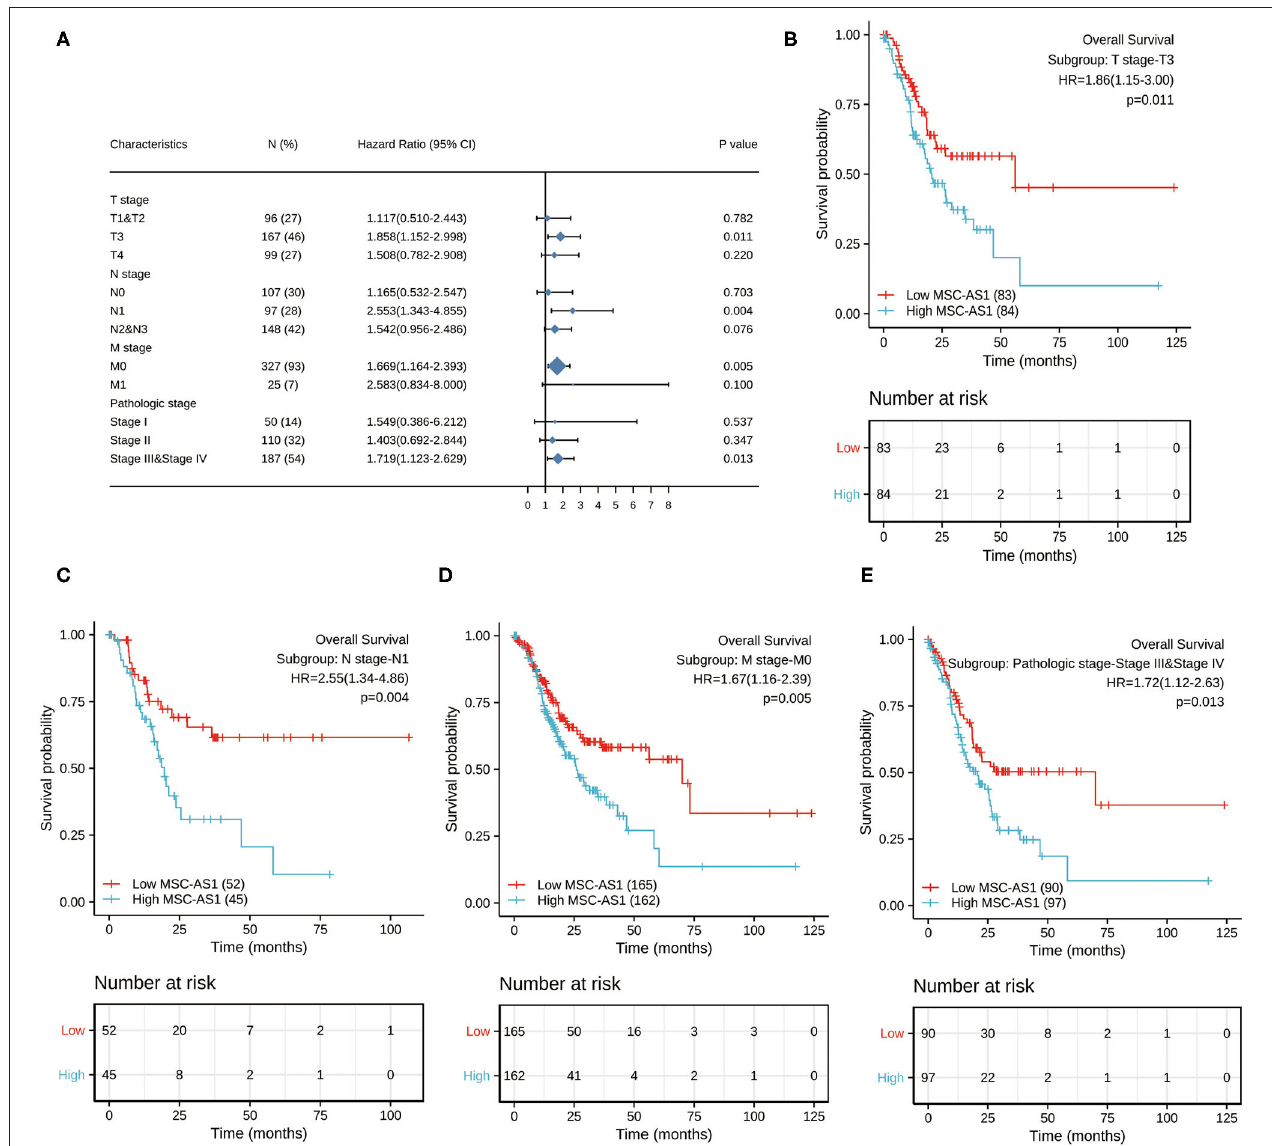
FIGURE 7 | (A) The prognostic value of MSC-AS1 in TCGA STAD subsets of gastric cancer in The Cancer Genome Atlas. Statistically significant subgroups were (B) T3; (C) N1; (D) M0; and (E) pathological stages III and IV. TCGA, The Cancer Genome Atlas; GC, gastric